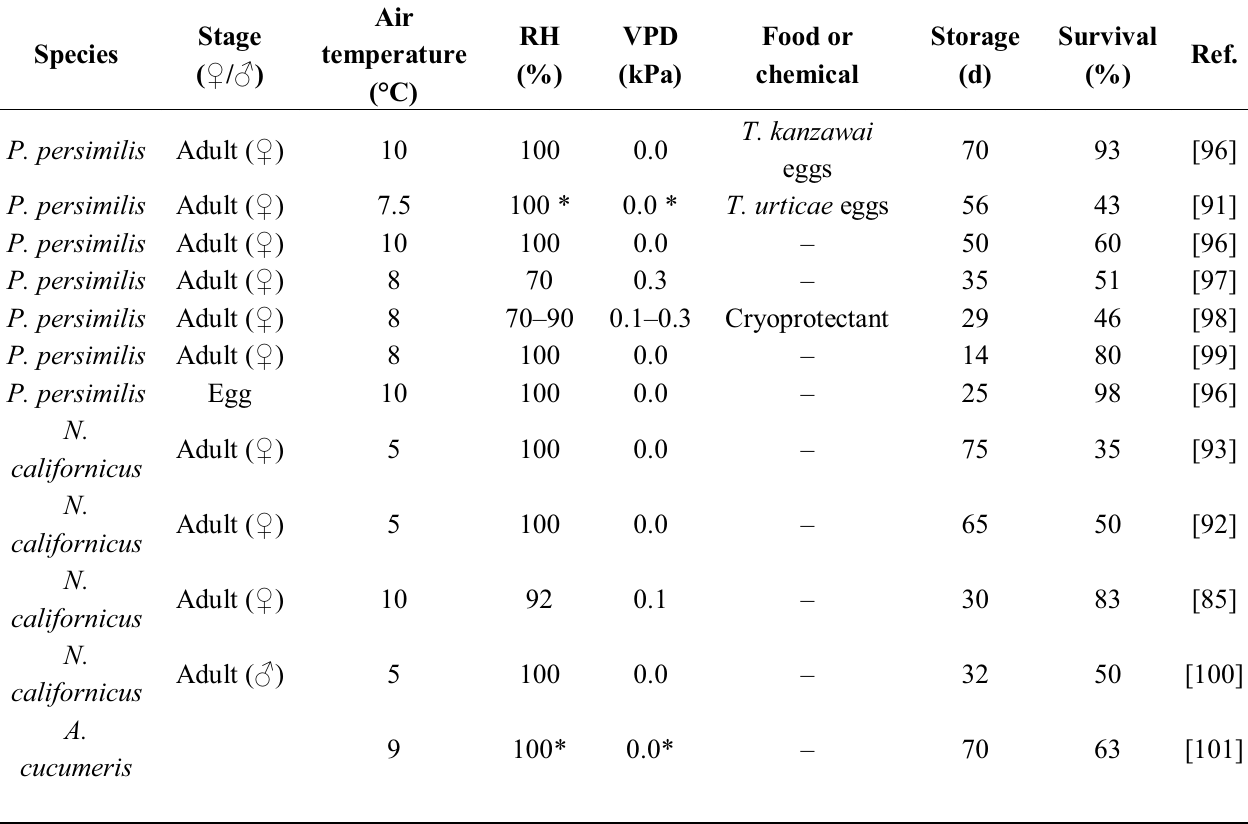
Table 1. Humidity-controlled cold storage of phytoseiid